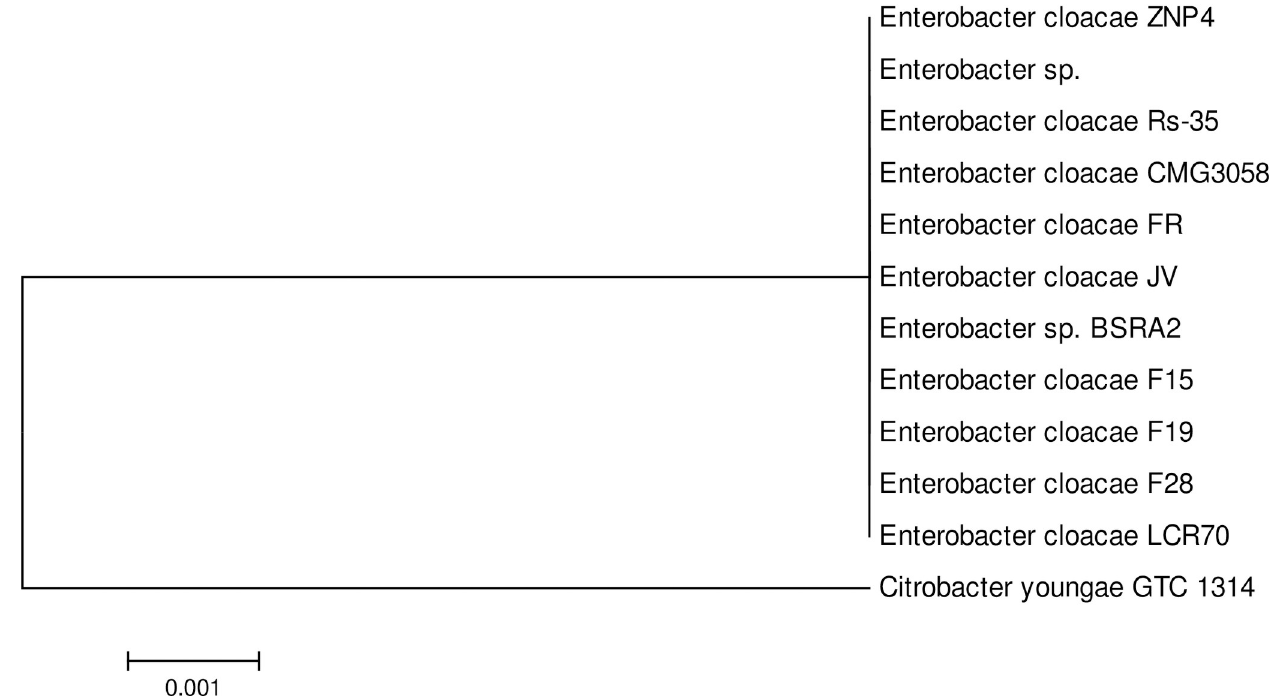
Fig 1. Phylogenetic tree of Enterobacter cloacae ZNP-4 using 16S rRNA gene sequences. The tree was constructed by neighbor-joining method at bootstrap value of (n = 500) using the software packages Mega version 6.0.